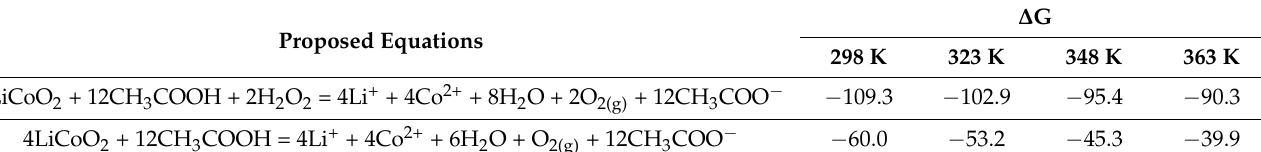
Table 2. Proposed LCO dissolution